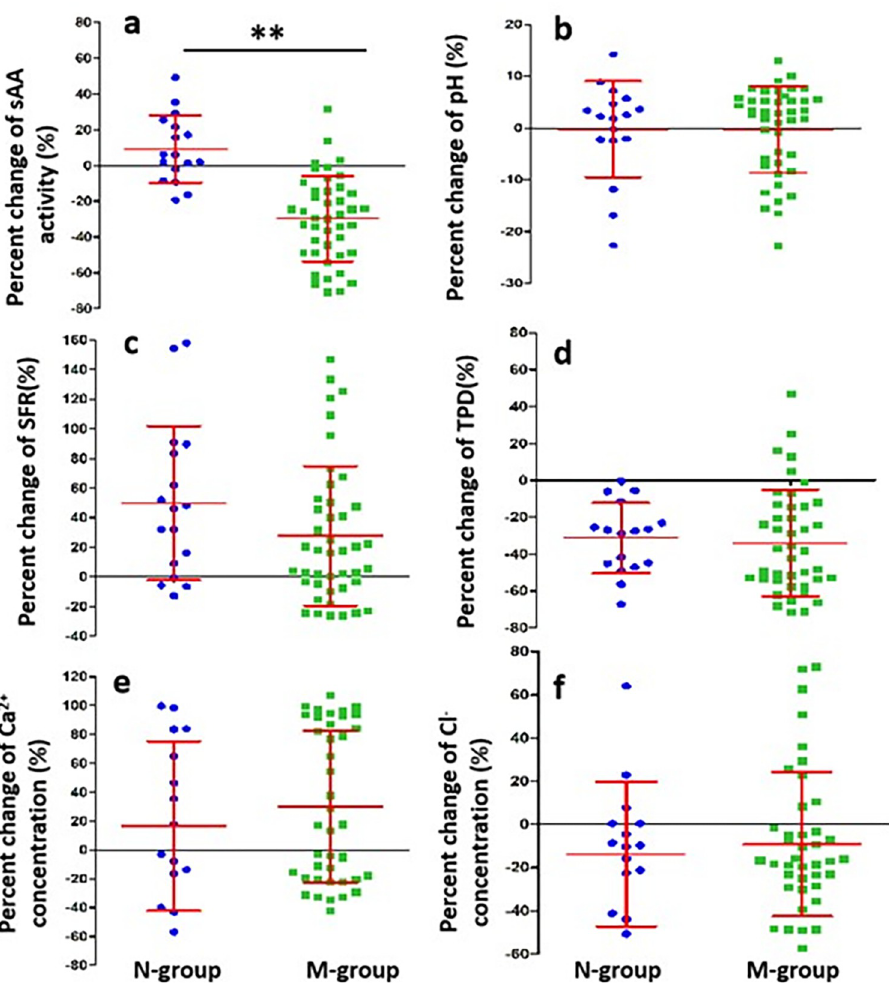
Fig 2. Percent changes in salivary indicators after acid stimulation in the N-group and M-group of MG. (a) : sAA activity, (b) : pH value, (c) : SFR, (d) : TPD, (e) : Ca 2+ concentration, (f) : Cl - concentration. Percent change reflects the extent of salivary secretion respond to acid stimulation and is calculated as [(value post-acid stimulation) − (value pre- acid stimulation)]/(value pre-acid stimulation) × 100%. N-group (n = 17) versus M-group (n = 43). The independent sample t test was applied at �� p < 0.01; data are expressed as mean ± SD.